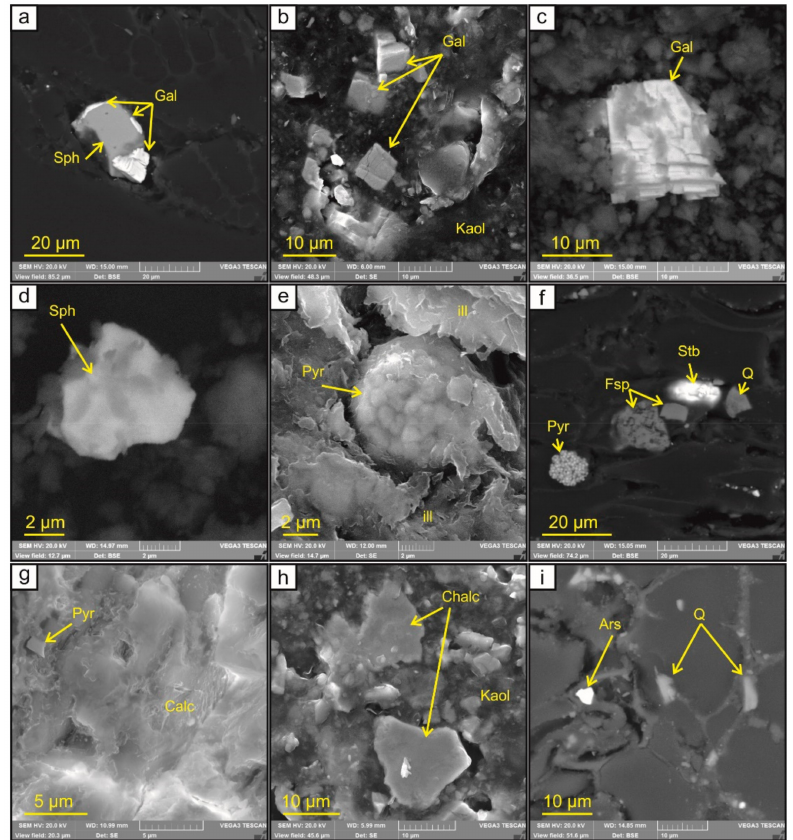
Figure 3. SEM images of sulfides in peat and basal sediments: ( a ) close association of sphalerite (Sph) and galena (Gal) in Sphagnum tissues; ( b ) euhedral galena microcrystals in kaolinite aggregate; ( c ) subhedral galena in smectite matrix; ( d ) anhedral sphalerite (Sph) crystal in smectite matrix; ( e ) pyrite (Pyr) framboid in illite (ill) aggregate; ( f ) pyrite framboid, subhedral stibnite (Stb), and clasts of quartz (Q) and feldspars (Fsp) in Sphagnum tissues; ( g ) subhedral pyrite crystal in calcite (Calc); ( h ) anhedral chalcopyrite crystals in kaolinite aggregate; ( i ) anhedral arsenopyrite and quartz clasts in Sphagnum tissues. The images are ( a , c , d , f , i ) backscattered and ( b , e , g , h ) secondary electron